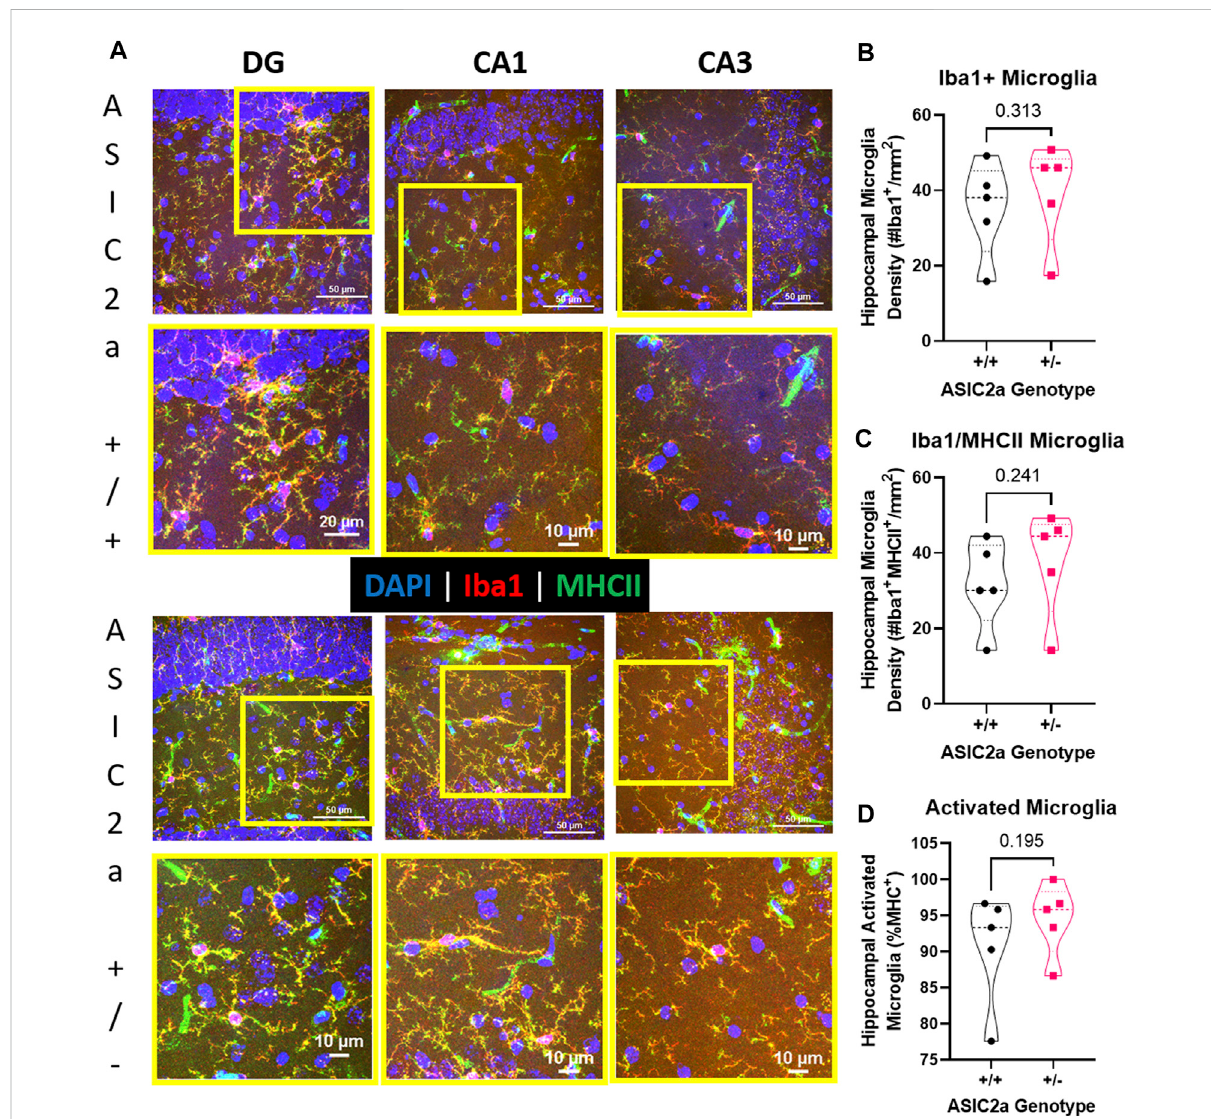
FIGURE 7 Hippocampalmicrogliachangesfollowingacuteseizureexposure. (A) Representativeimagesfromdentategyrus(DG),CA1,andCA3areshown for ASIC2a +/+ and ASIC2a +/- mice. Yellow squares represent the selected fi eld for the higher magni fi cation images (shown below). Majority of the microglia co-expressed major histocompatibility complex II (MHCII). Scale bars represent 50 µm or 10 µm. Microglia density was determined in images from dentate gyrus, CA1, and CA3 and averaged to obtain hippocampal microglia density based on the expression of (B) Iba1, (C) Iba1/ MHCII, and (D) percentage of Iba1/MHCII to total Iba1+ microglia. Individual data points are displayed. Thick dashed line is the median and the thin dashed lines are the quartiles Signi fi cance was calculated using Mann-Whitney U